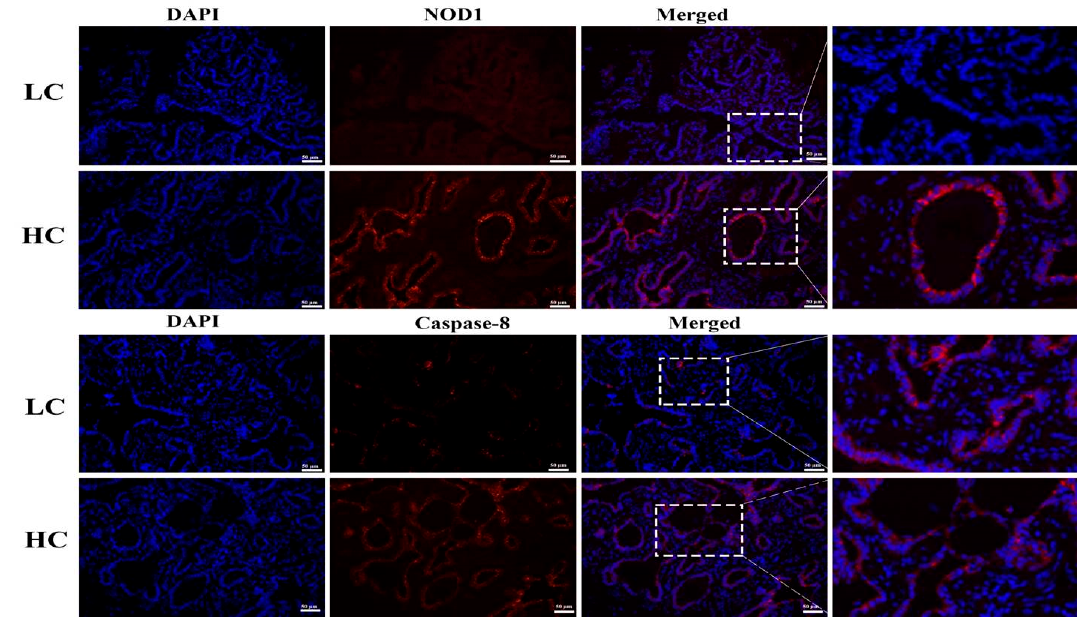
Figure 5. Localization of NOD1 and Caspase-8 proteins was detected through IFA. An increased level of red staining (CY3) of NOD1 and Caspase-8 proteins was observed in the HC group compared to the LC group in mammary tissue epithelial cells of dairy cows, with DAPI blue nucleus staining being conducted during the immunofluorescence examination. The images were taken at a 50 µ m scale bar. The white rectangular selected area shows an enlarged area.